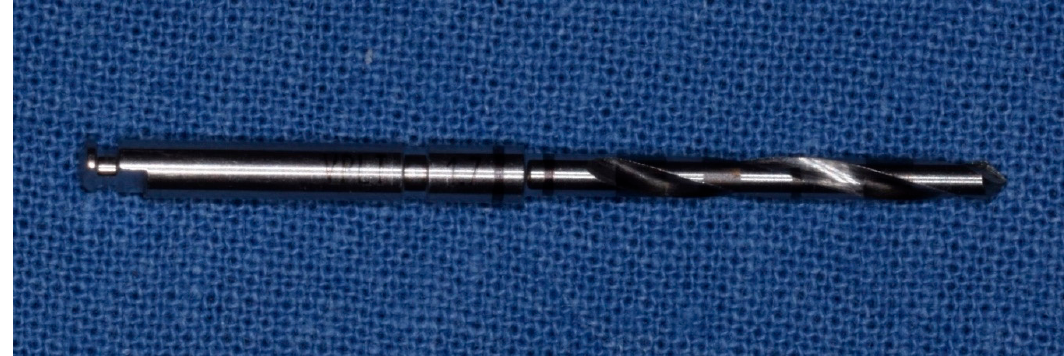
Figure 5. Initial drilling pilot cutter of the method “implant drilling with bone compaction instrumentation technique.”